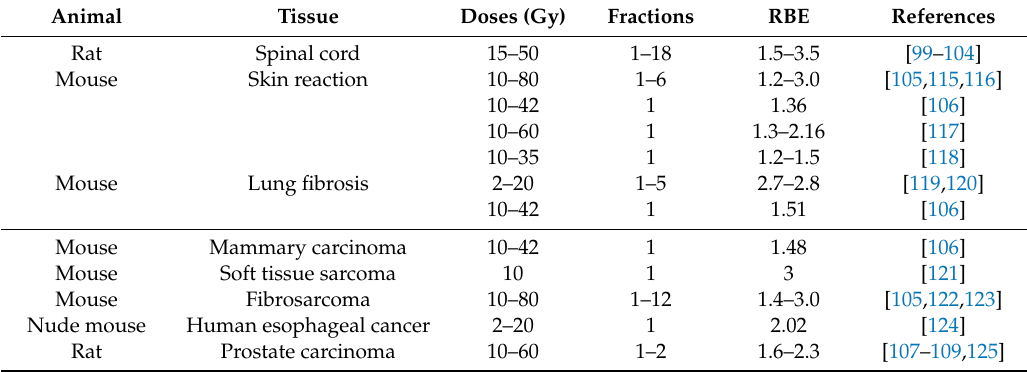
Table 2. Animal experiments measuring the RBE of C-ion beams in therapeutic conditions. Both normal tissue complication scores and tumor growth delay experiments are